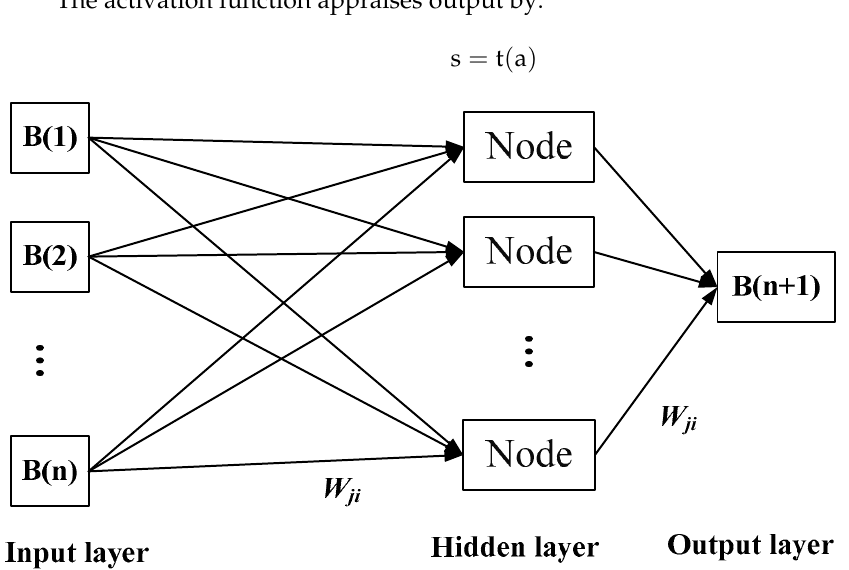
Figure 2. The architecture of the artificial neural network predicting PM 2.5 concentration.